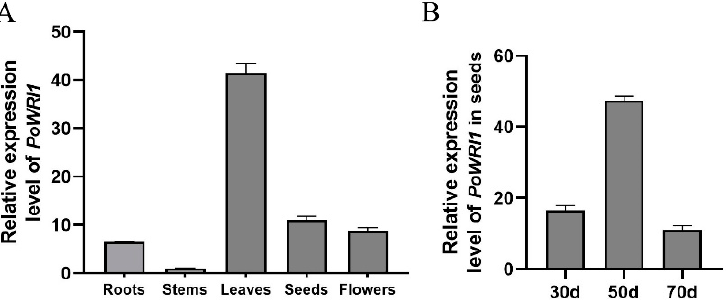
Figure 3. Expression level analysis of PoWRI1 in P. ostii . ( A ) Relative expression level of PoWRI1 of different tissues in P. ostii . The reference gene was Ubiquitin (JN699053), the primers were based on the coding sequences of PoWRI1 (MW930196). Total RNA was extracted from roots, stems, leaves, flowers, and seeds (70d) of P. ostii . Values are the means ± SE of three replicates carried out on cDNAs obtained from three independent mRNA extractions. ( B ) Relative expression level of PoWRI1 in seeds of different stages. The reference gene was Ubiquitin (JN699053), the primers were based on the coding sequences of PoWRI1 (MW930196). Total RNA was extracted from the seeds of 30d, 50d, and 70d. Values are the means ± SE of three replicates carried out on cDNAs obtained from three independent mRNA